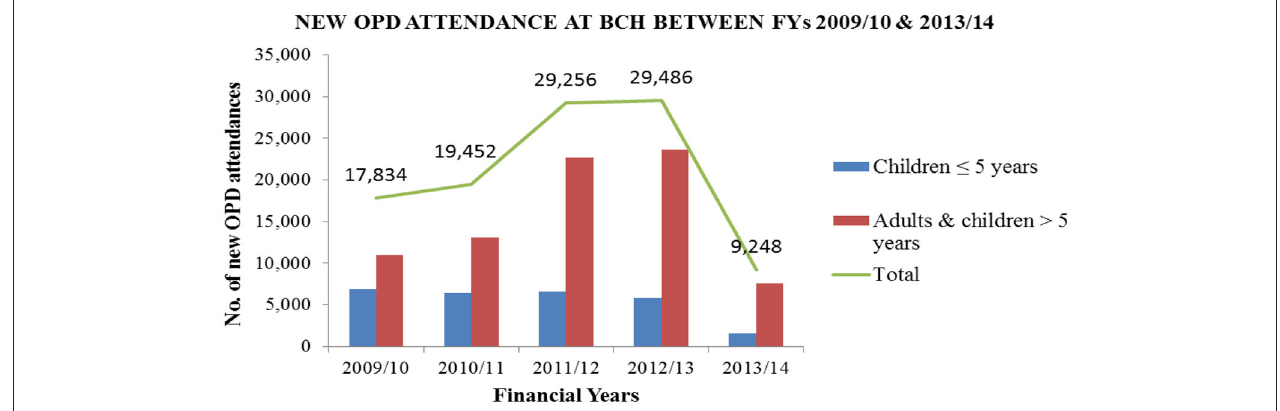
FIGURE 1 | Utilization of OPD services at BCH for the financial years 2009/10 to 2013/14.